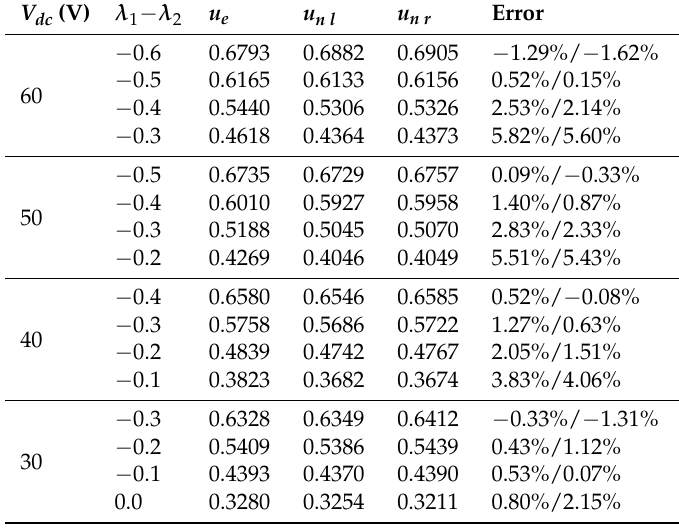
Table 2. The comparison of transition points obtained with two methods.